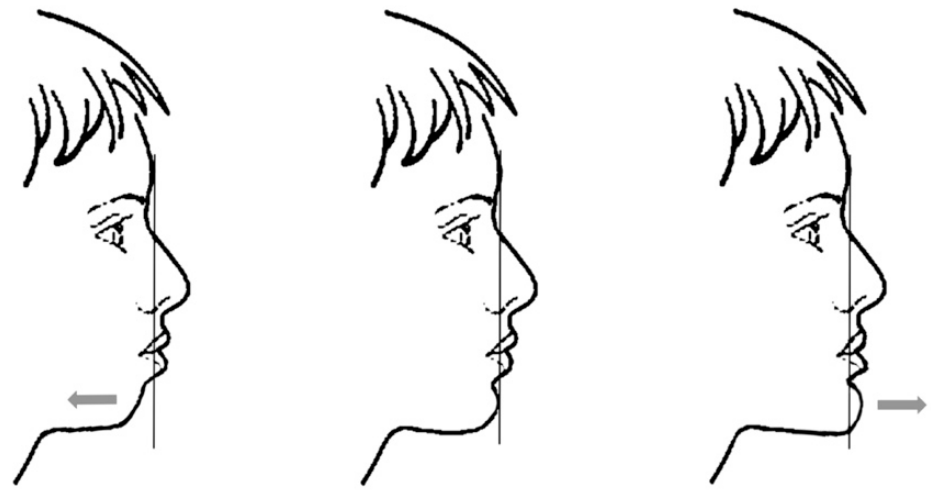
Figure 2. Sagittal position of the chin related to the vertical line from the glabella cutaneous point. (2) vertical position The trichion (the hairline point), glabella, subnasal (the limit between the upper lip and the nasal contour) and cutaneous gnathion (lower limit of the chin) points divide the face into three parts (Figure 3). Artists well know that when these three parts are approximately equal, the face is in good vertical aesthetic harmony. When the lower third vertical skeletal problem. In this study, the authors considered abnormal a vertical chin position <2 or >2 mm related to the middle